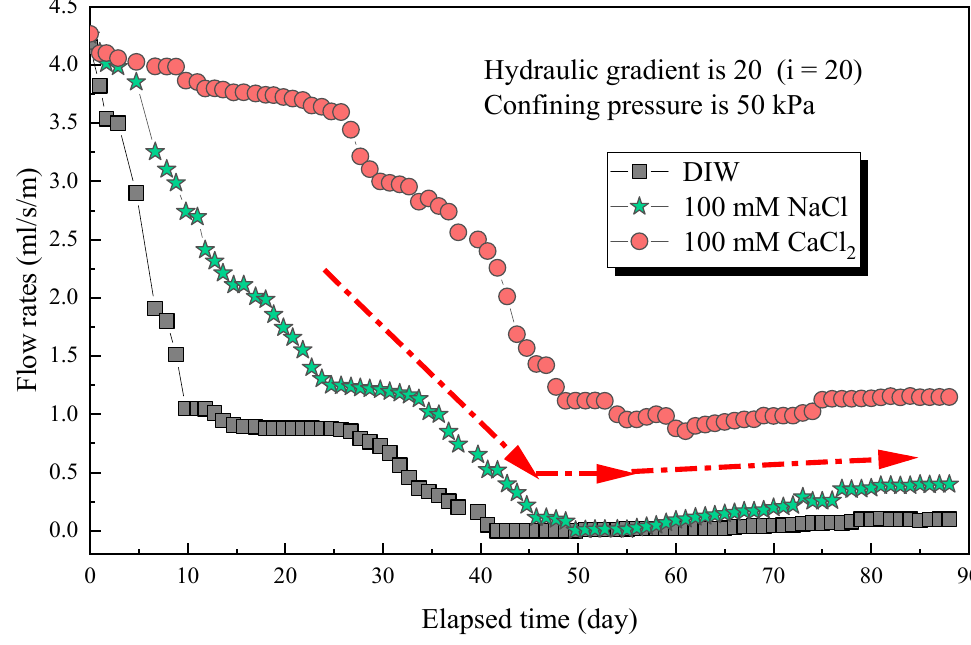
Figure 7. The flow rates with elapsed time of poor-sealing specimens permeated with different testing liquids.